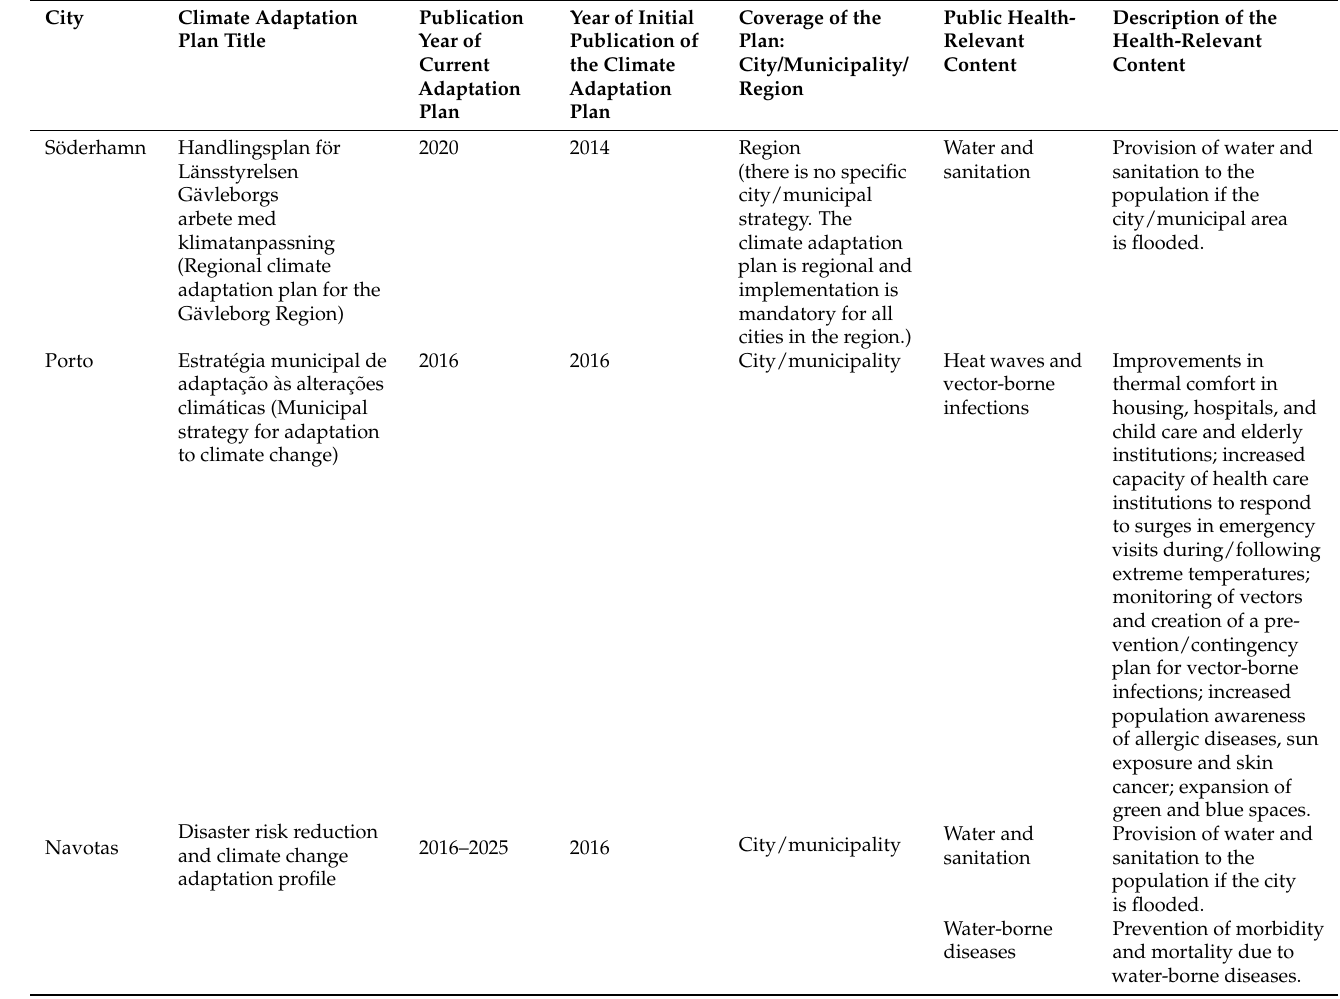
Table 1. Public health aspects of climate change adaptation plans published on the websites of the cities of Söderhamn (Sweden), Porto (Portugal) and Navotas